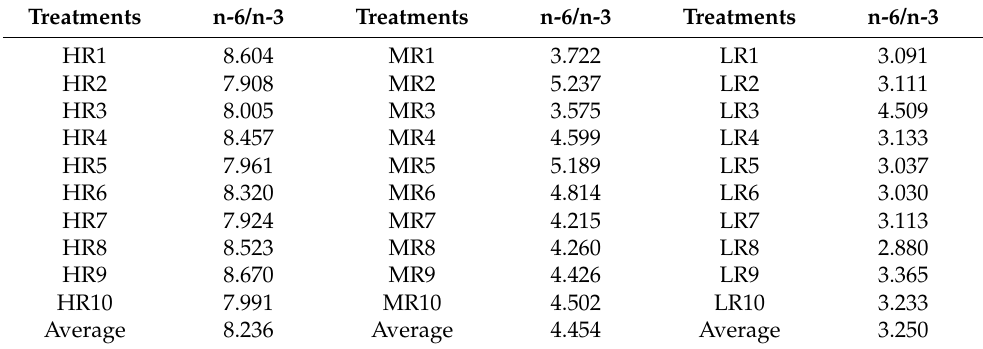
Table 1. The ratio of n-6 to n-3 fatty acids in each group of samples. Treatments